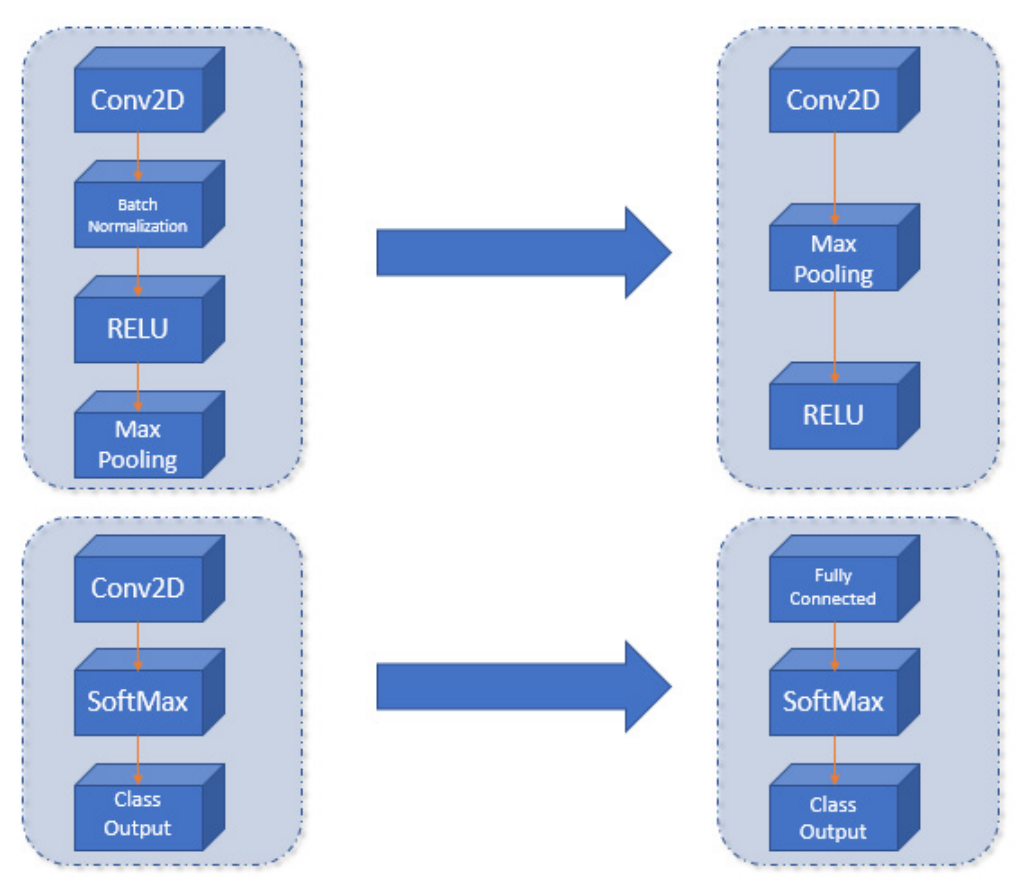
Figure 6. Proposed changes in the Darknet architecture ( left ) to create the new CNN ( right ).